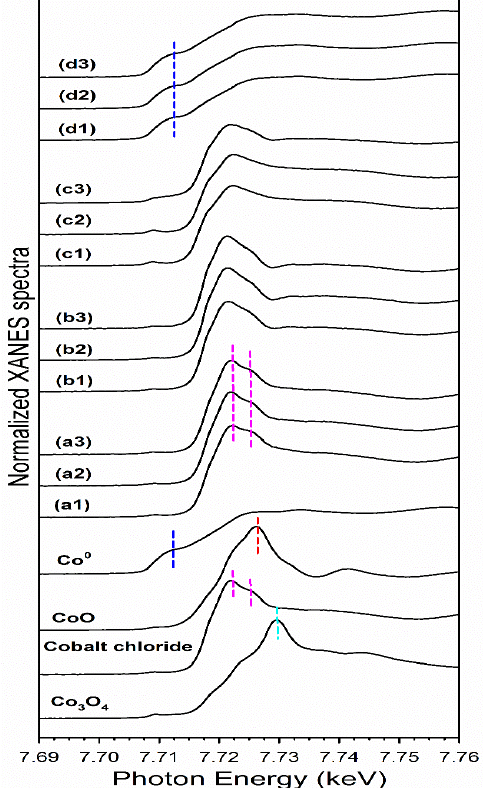
Figure 13. XANES snapshots of (bottom) references for Co 3 O 4 , CoO, and Co 0 obtained from the TPR-XANES trajectory of the calcined 25% Co/Al 2 O 3 catalyst and for the cobalt chloride obtained in the initial spectrum of the uncalcined unpromoted catalyst. XANES snapshot spectra for samples prepared from cobalt chloride along the TPR trajectory include (1) the calcined catalyst, (2) the uncalcined catalyst and (3) the uncalcined catalyst with 0.5% Pt promoter at ( a ) the point of maximum cobalt chloride, ( b ) the point of partial cobalt chloride decomposition #1, ( c ) the point of partial cobalt chloride decomposition #2, and ( d ) the point of maximum Co 0 content following TPR. Dashed lines emphasize: (pink) Co 2+ in cobalt chloride, (cyan) Co 3+ (i.e., in addition to Co 2+ ) in the spinel, (red) Co 2+ in CoO, and (blue) Co 0